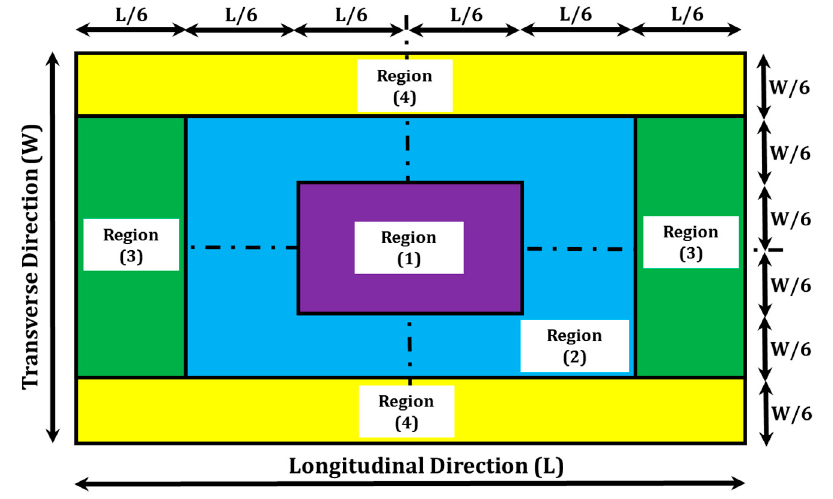
Figure 24. Damage index concept.